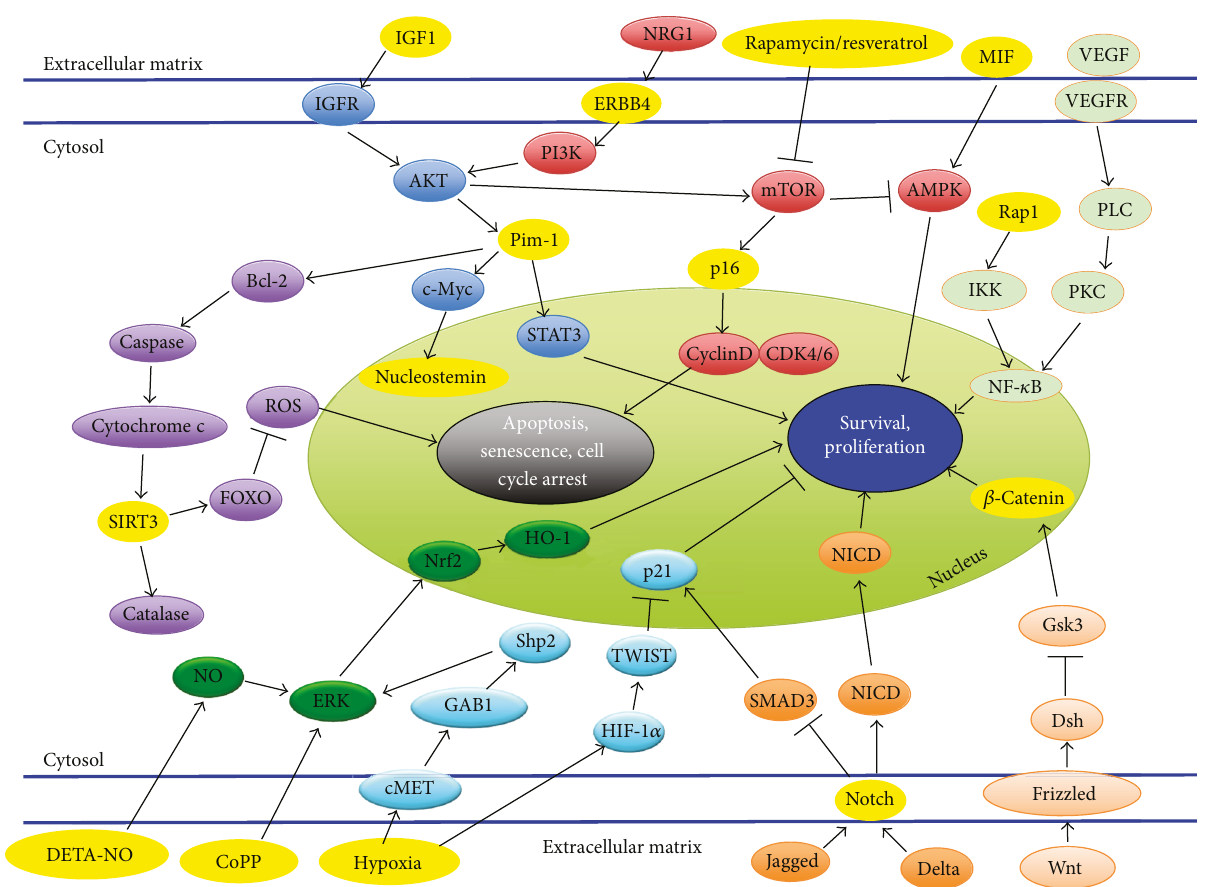
Figure 2: Molecular signaling pathways that are associated with rejuvenating aging stem/progenitor cells. Those that are currently being studied and were discussed in this review are highlighted in